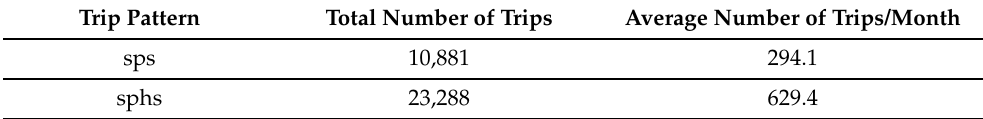
Table 6. The total number and the average number of trips per month and per trip